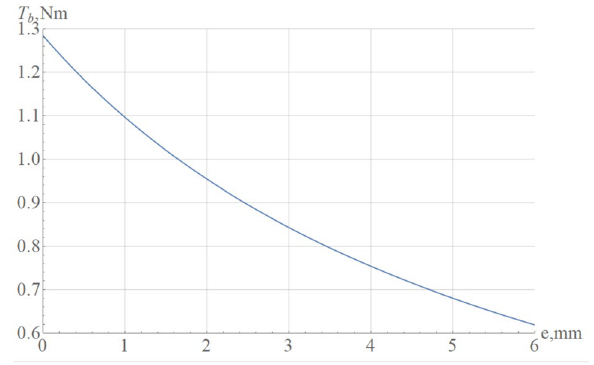
Fig. 4 Stop torque